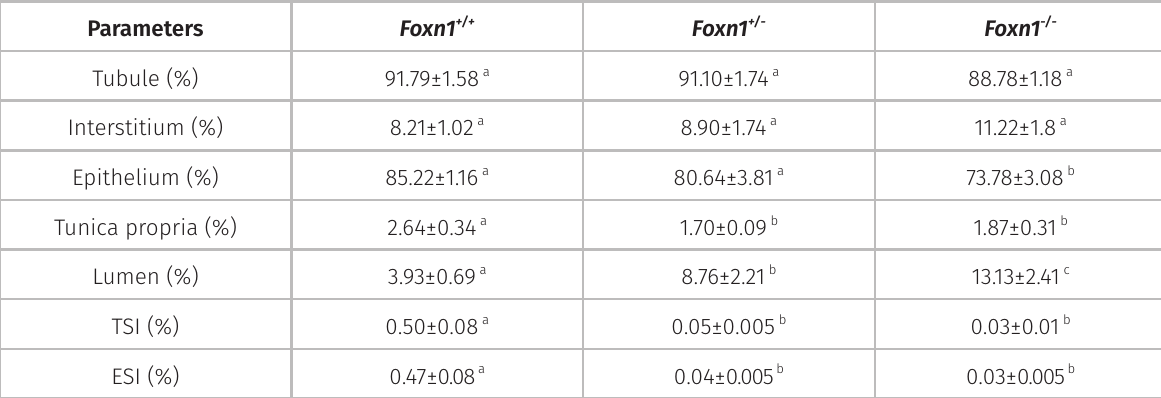
Table I. Proportions and indexes of the seminiferous tubules components.